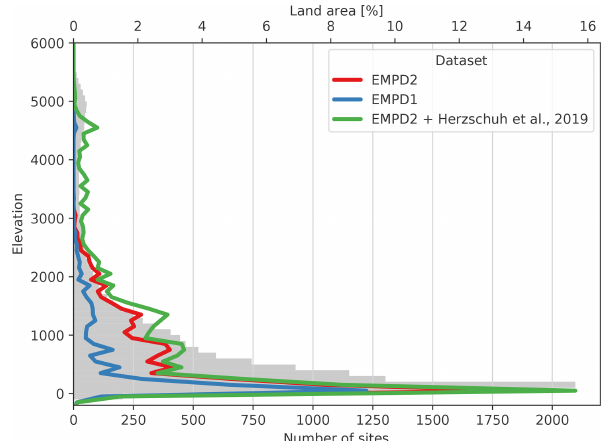
Figure 4. Distribution of samples by altitude for the Palearctic re- gion (compared to land area at each